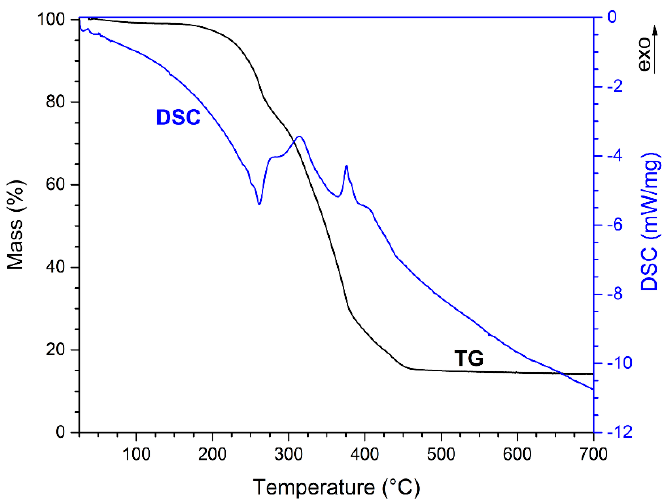
Figure 4. Thermal analysis of precursor mixture F.